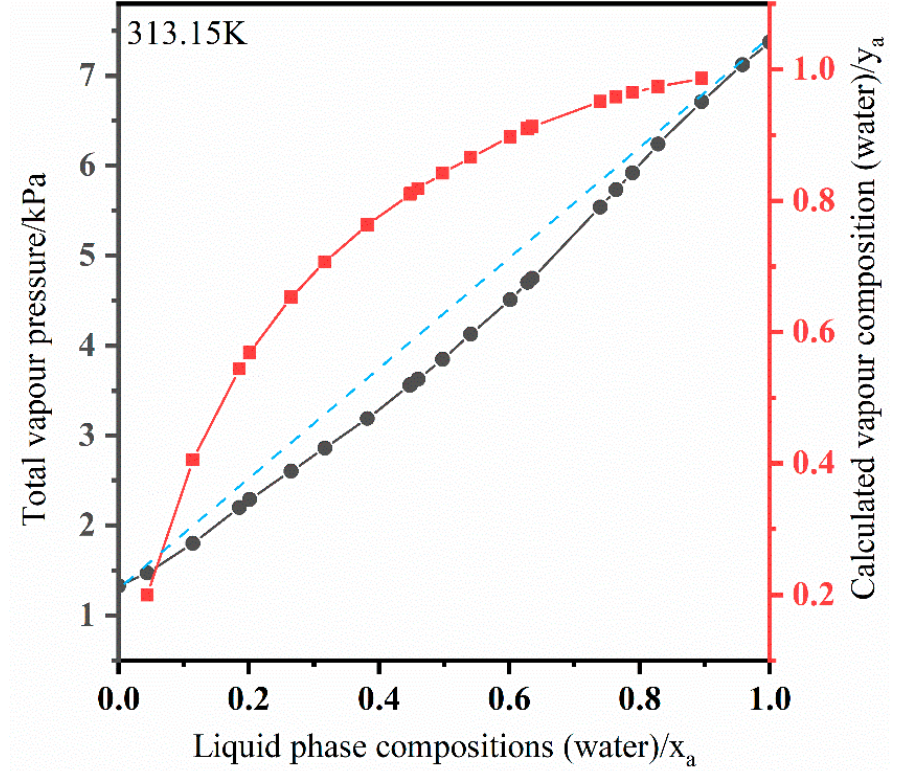
Figure 5. Vapor–liquid equilibria of DMF + water as a function of mole fraction of water. Table 1. Total vapor pressure measurements of DMF + water. Reprinted with permission from ref. [25]. Copyright 1990 Elsevier.